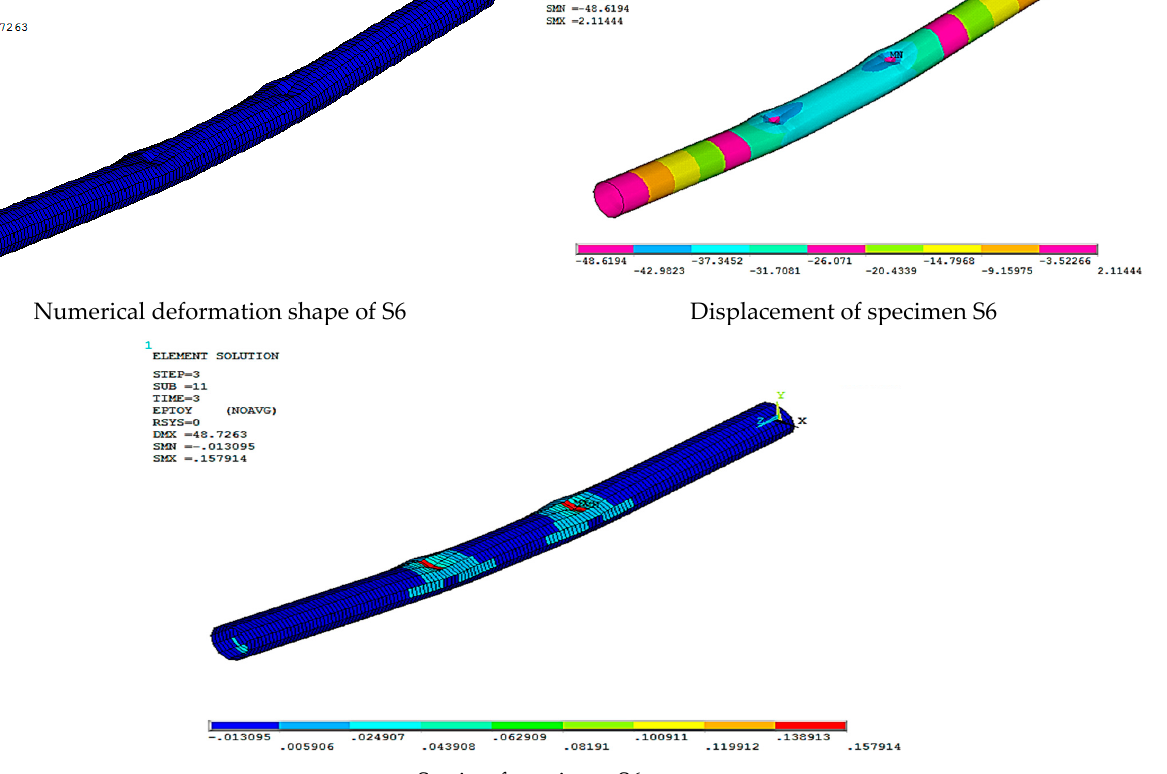
Figure 21. Numerical analysis of S6.